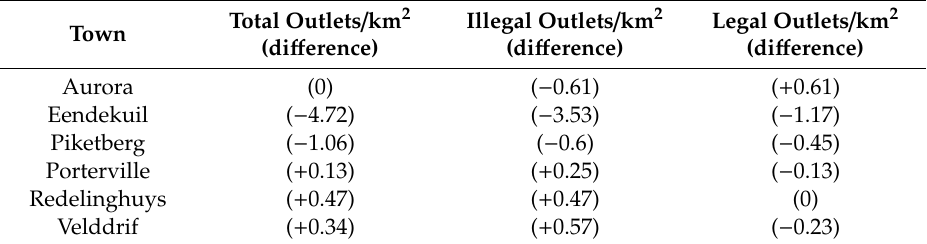
Table 4. Outlets / km 2 between two datasets.